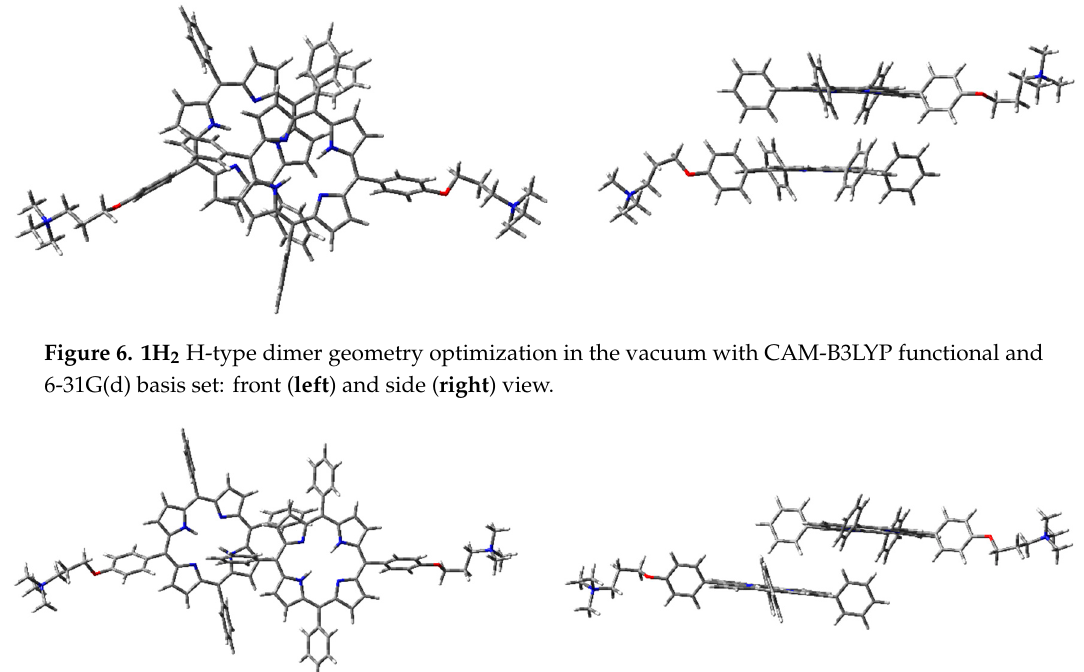
Figure 7. 1H 2 J-type dimer geometry optimization in the vacuum with CAM-B3LYP functional and Molecules 2019 , 24 , x FOR PEER REVIEW 6-31G(d) basis set: front ( left ) and side ( right ) view.